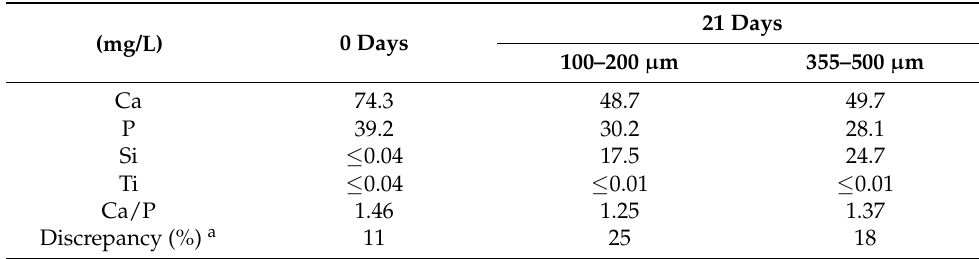
Table 2. Chemical composition of SBF by ICP. Influence of the pore size distribution on the formation of HA (Ca/P ratio).